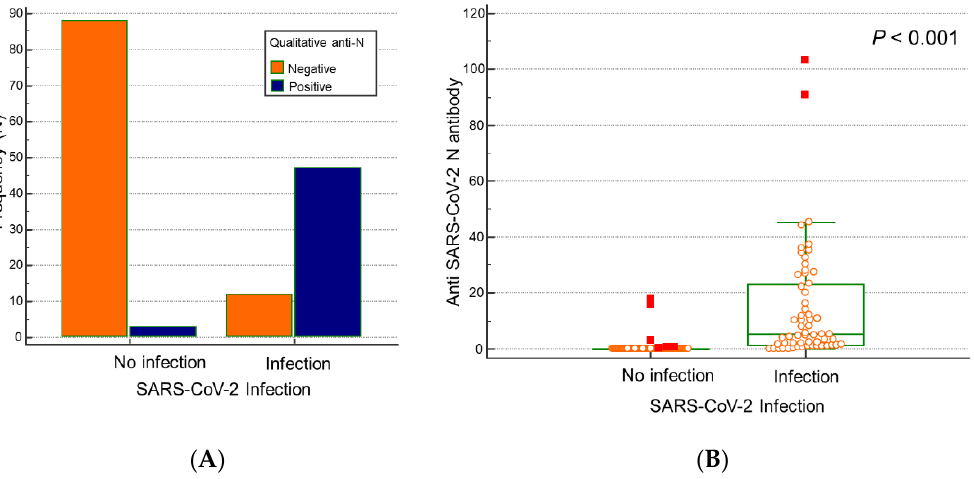
Figure 2. Quantitative and qualitative serological responses for anti-N antibodies after 4 months after the third dose of vaccination (T2). ( A ) Number of participants with anti-N positivity was significantly higher in the SARS-CoV-2-infected group than in the non-infected group. ( B ) The SARS-